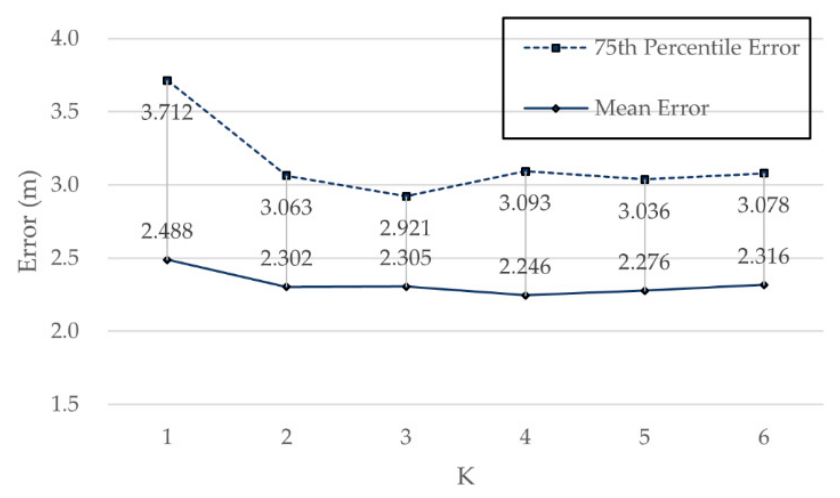
Figure 9. Positioning errors for different K based on WKNN on Zenodo.